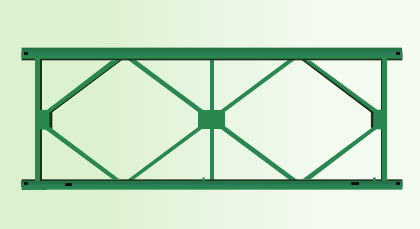
Figure 1: The “321” fabricated highway steel bridge truss panel.